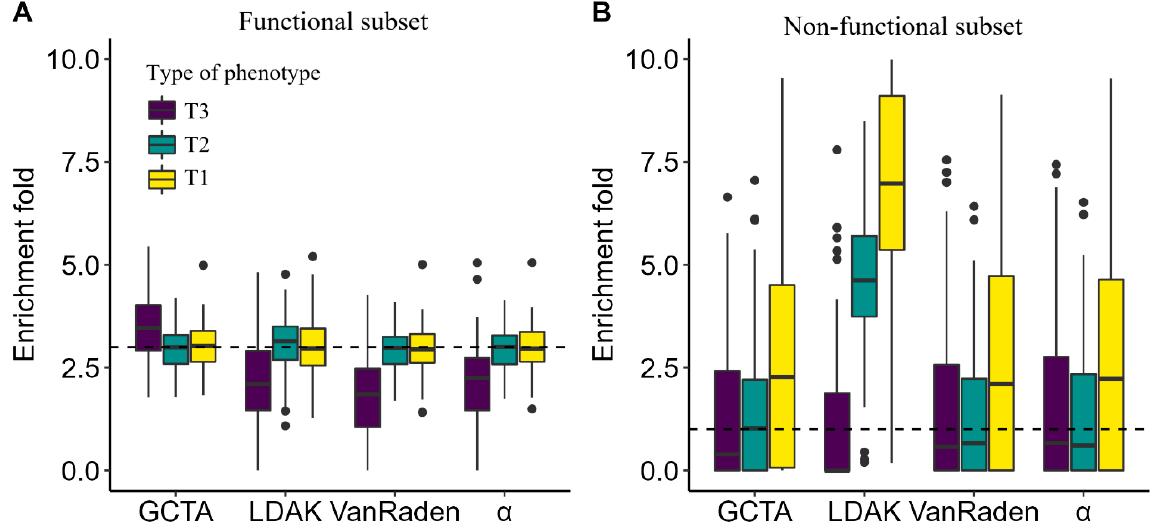
Figure 1. Comparison of heritability enrichment estimation models. Showing the estimated enrich- ment for different models integrated with ( A ) “Functional subset” or ( B ) “Non-functional subset”. Colors represent the type of phenotype. The dotted lines represent the true enrichments (i.e., 3.000 and 1.000, respectively).